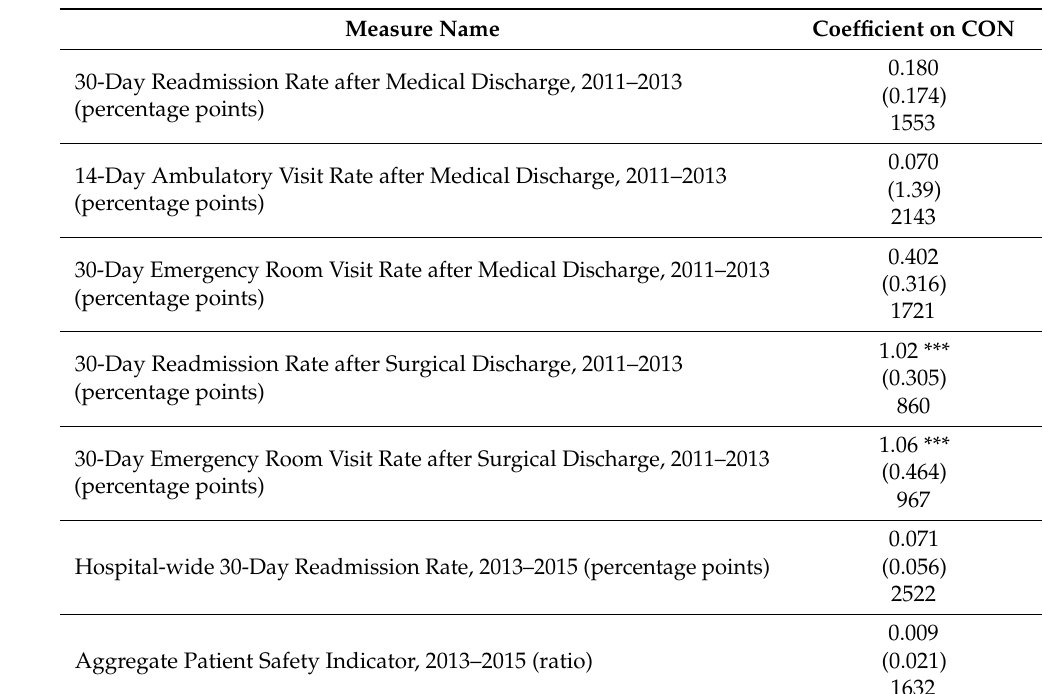
Table 12. Regression results for aggregate quality